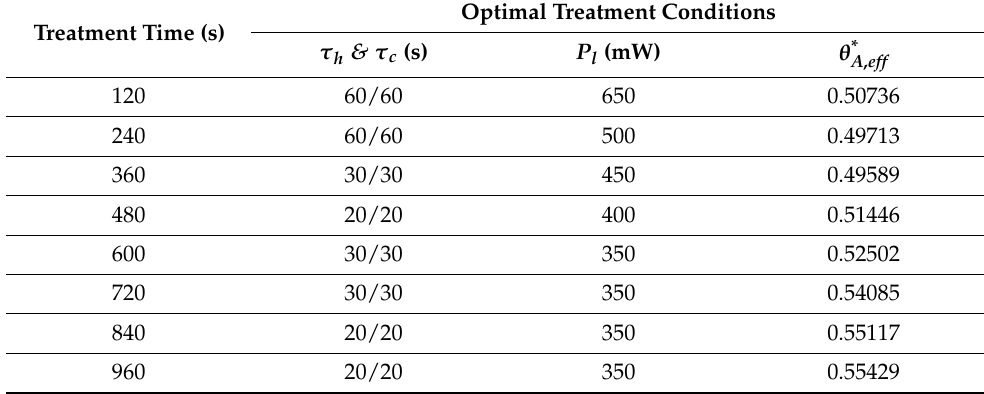
Table 7. Best treatment effect condition and effective apoptosis retention ratio for various treat- ment